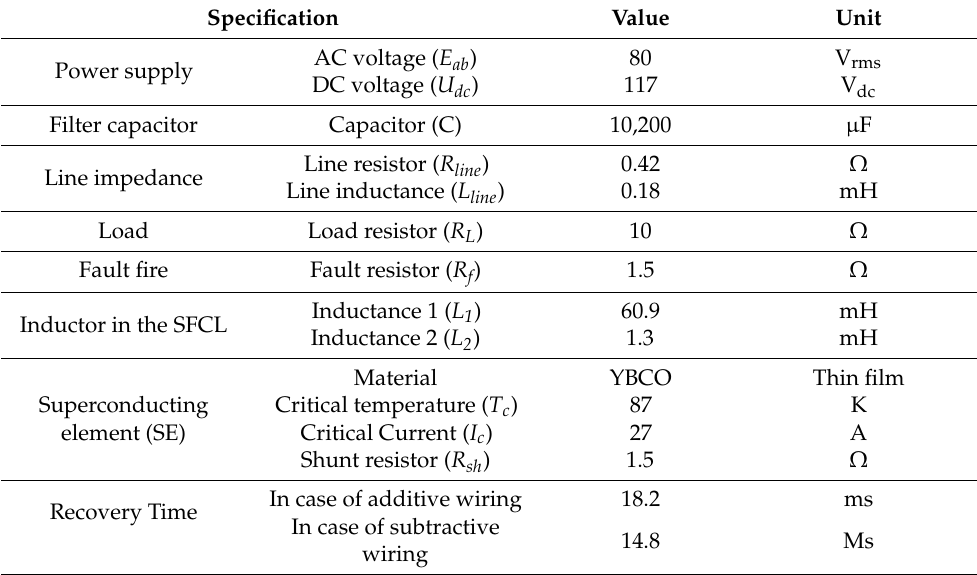
Table 1. Experimental specifications of the DC system models, including the flux-coupled type